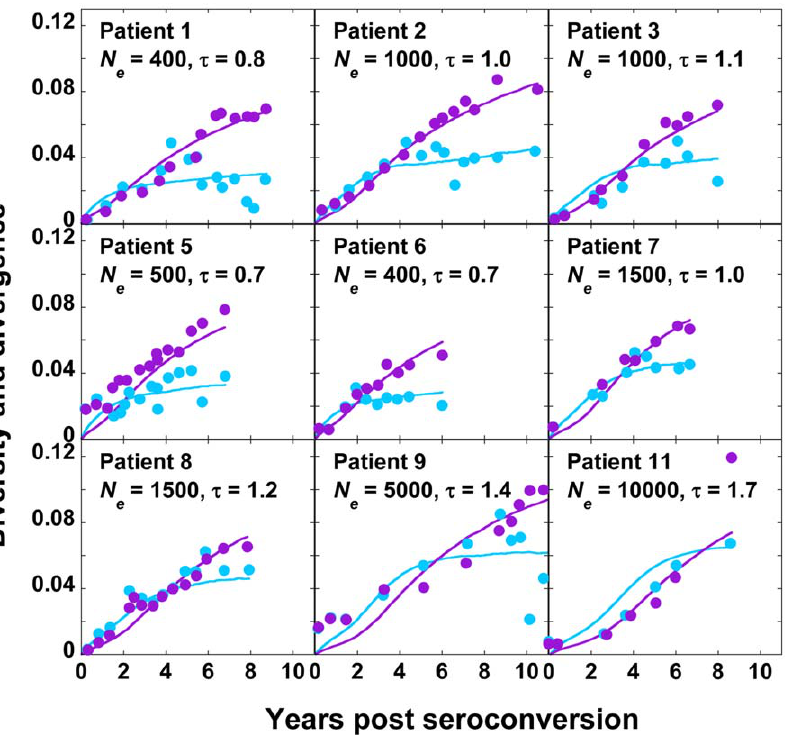
Figure 3. Fits of our simulations to data from patients. Best-fit predictions of our simulations (solid lines) presented with experimental data (symbols) of the evolution of viral diversity, d G , (cyan) and divergence, d S , (purple) for each patient. Each cell is assumed to be infected with M =3 virions in our simulations. The values of N e (cells) and t (days) employed for the predictions are indicated.